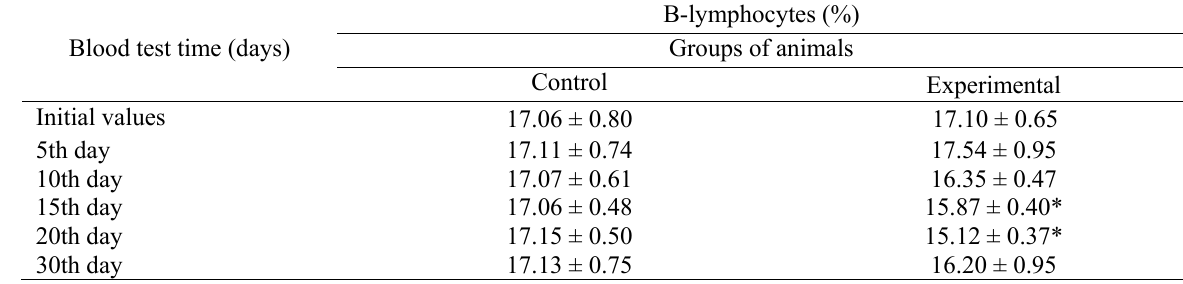
The number of B-lymphocytes in the blood of bulls under the influence of chronic cadmium toxicosis (М ± m, n = 5) Blood test time